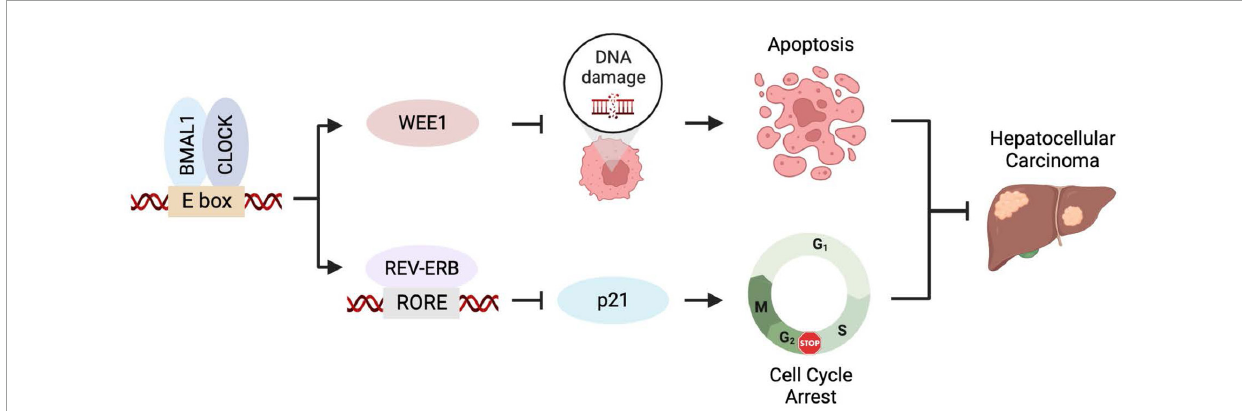
FIGURE1 BMAL1::CLOCK promotes HCC growth by controlling cell cycle regulators. BMAL1::CLOCK directly activates the transcription of WEE1 but inhibits p21 expression via regulating the REV-ERBs level. Inhibition of BMAL1::CLOCK downregulates WEE1 leading to mitotic catastrophe and apoptosis and elevates p21 level that causes cell cycle arrest. The two mechanisms collaboratively contribute to the pro-proliferative activity of BMAL1::CLOCK in HCC.